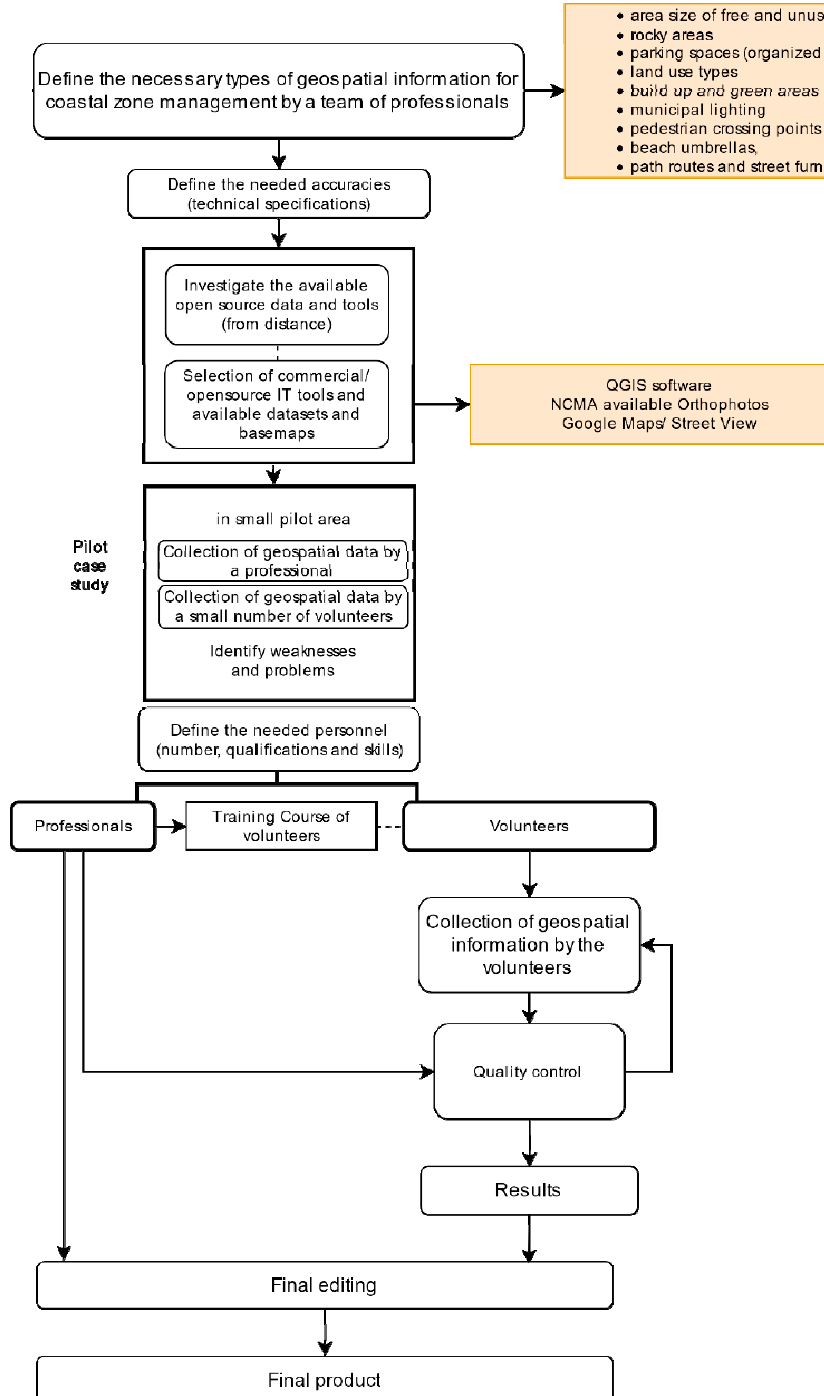
Figure 1. Methodology framework for remote crowdsourced geospatial data collection for coastal management and planning for emerging tourism demand. Source: own elaboration.